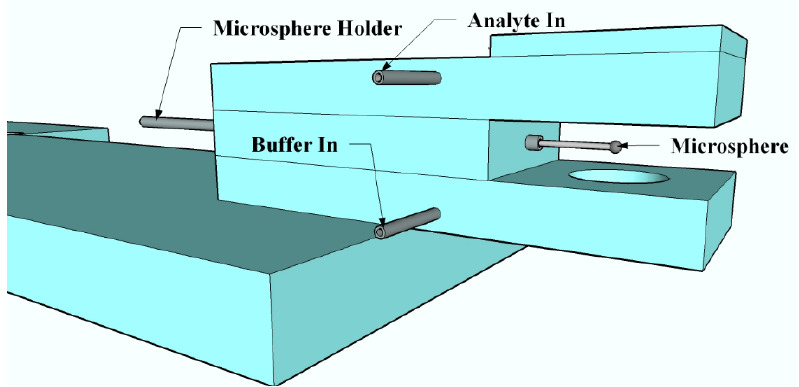
Figure 7. A model of the open-flow flow cell used for sensing experiments. This cell has injection ports for both the test molecule (avidin, lysozyme, or fibrinogen) and the PBS buffer